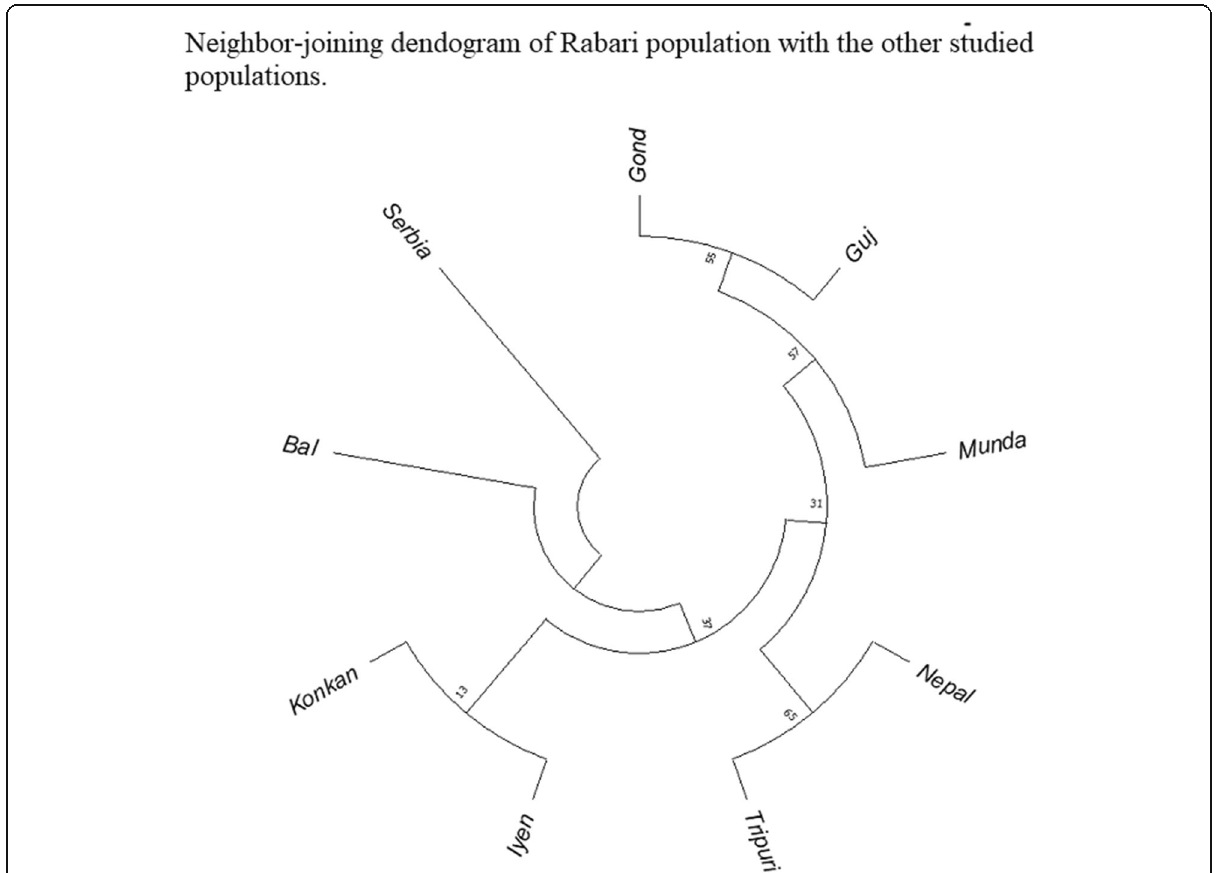
Fig. 2 Neighbor-joining dendogram showing the relationship of Rabari population with the previously reported populations. The tree was constructed based on allele frequencies for 15 autosomal STR loci shared among all populations (D2S1338, D3S1358, D5S818, D7S820, D8S1179, D13S317, D16S539, D18S51, D19S433, D21S11, CSF1PO, FGA, TH01, TPOX, and